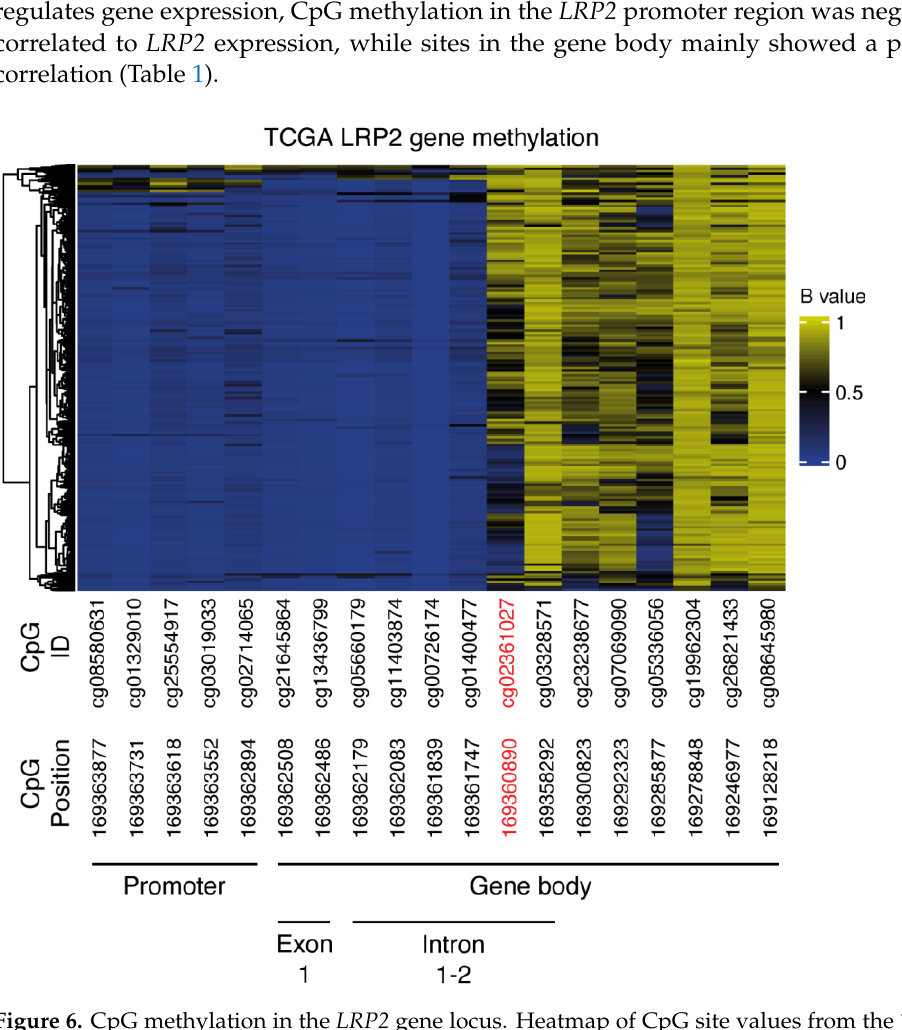
Figure 6. CpG methylation in the LRP2 gene locus. Heatmap of CpG site values from the 19 CpG sites in the LRP2 gene included in the Illumina450K TCGA Pan-Cancer dataset. LRP2 β values for each CpG site in KIRC, KIRP, MESO, THCA, BRCA, LUAD, and SKCM are shown. CpG ID, CpG position on chromosome 2 (GRCh38) and location relative to the full-length LRP2 transcript (ENST00000649046) are shown below the heatmap. cg02361027 at position 169360890, which shows a strong inverse correlation to LRP2 expression, is highlighted in red.